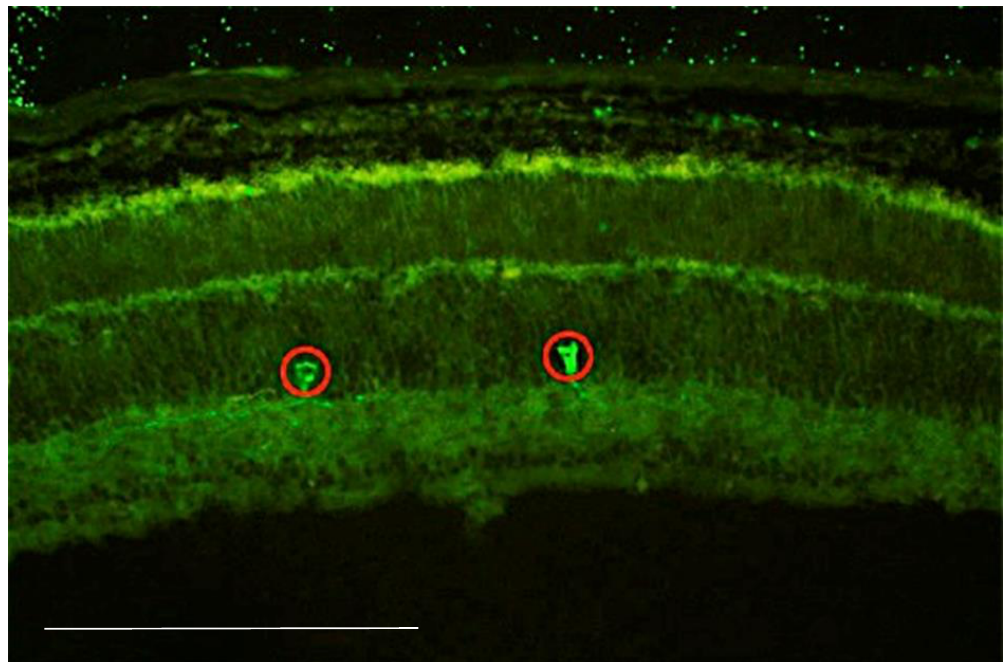
Figure 2. Image of a retina from a postnatal 11-day rd1 mouse, showing immunostaining for neuronal nitric oxide synthase (nNOS). Immunofluorescent staining was performed on retinal cryosections that were incubated overnight with the primary antibody anti-neuronal nitric oxide synthetase (anti-nNOS) (1:200, Santacruz Biotechnology, Dallas, USA). The sections were later incubated with the fluorescence-conjugated secondary antibody Alexa Fluor 488 (Invitrogen, Life Technologies, Madrid, Spain). (Scale: 200 µ m). Retinitis Pigmentosa Treatment with Nitric Oxide Synthase